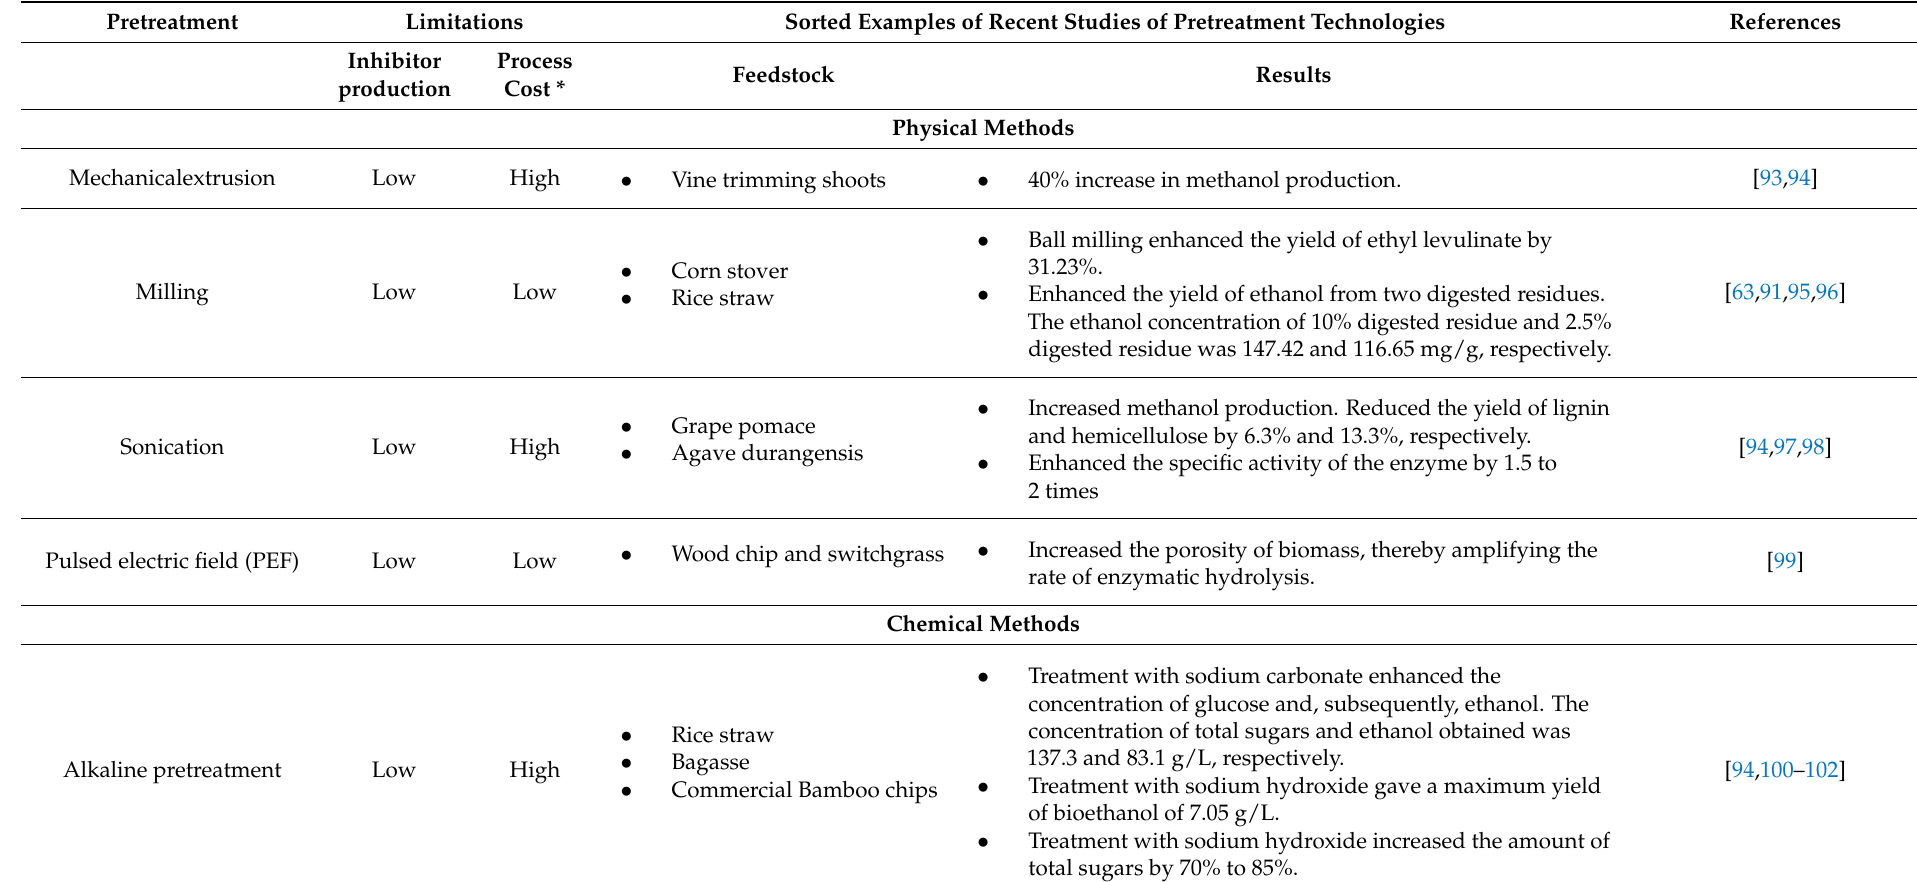
Table 3. Summary of limitations and recent literature of different pretreatment